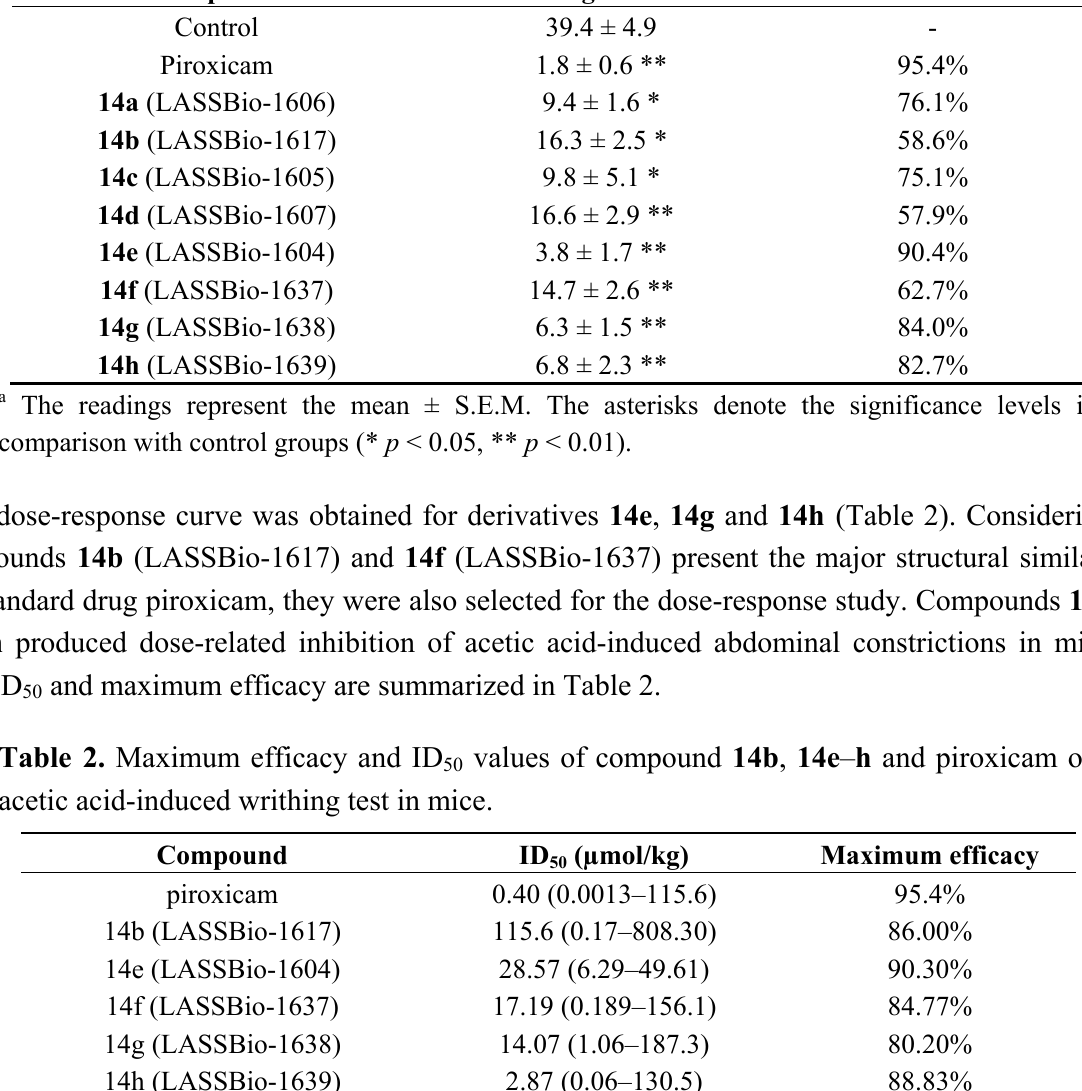
values of compound 14b , 14e – h and piroxicam on 50